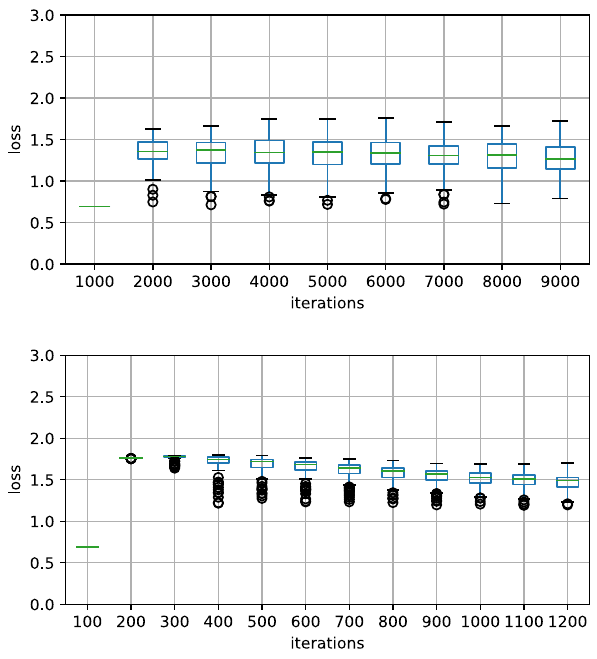
Fig. 16 The loss of high-frequency words on W2V-Vanilla model (upper subfigure) and W2V-CL model (lower subfigure). The size of boxes indicates the variance